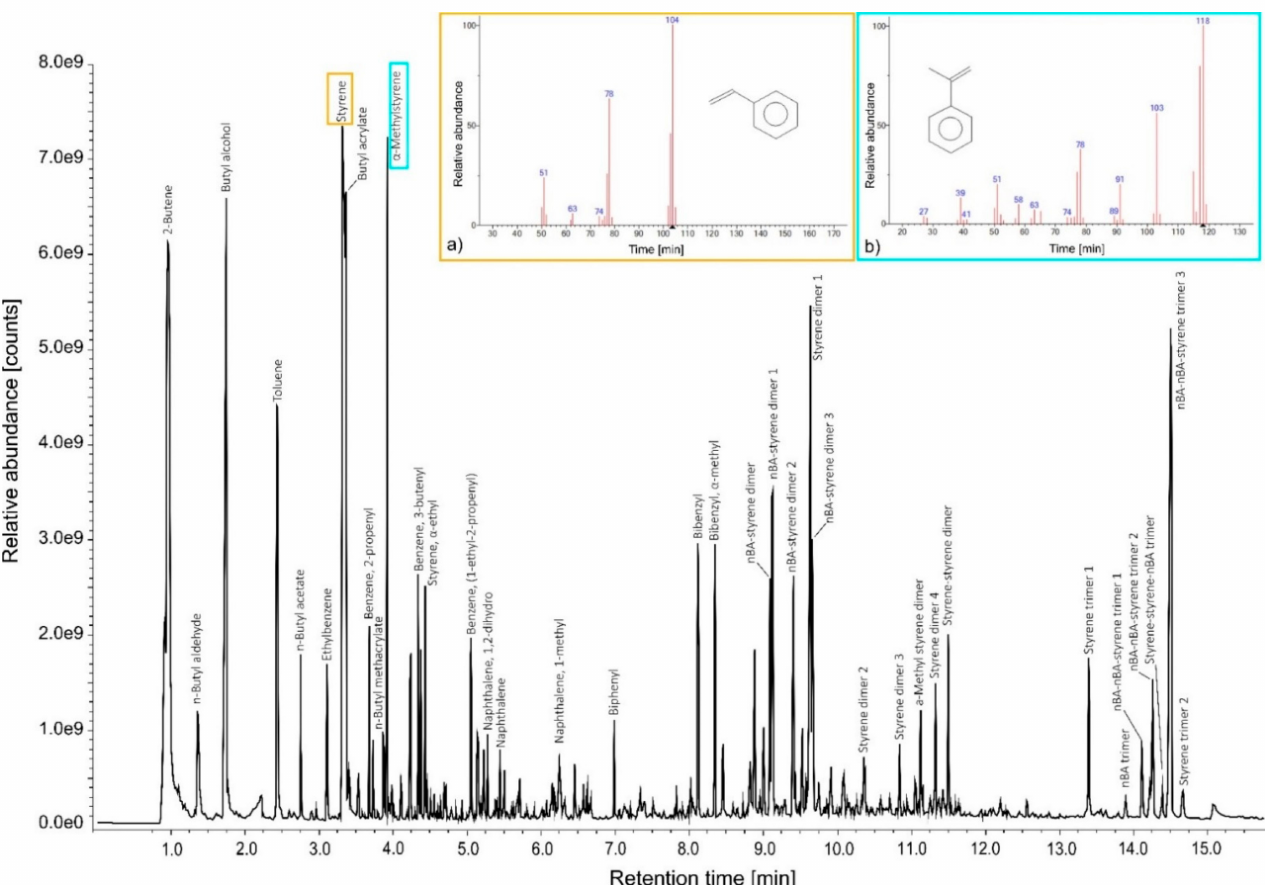
Figure 4. TIC (total ion current) pyrogram obtained after Py-GC/MS analysis of the pure unaged styrene-acrylic emulsion fragments. ( a ) Styrene; ( b ) α -Methylstyrene. Mass spectra of the highest intensity peaks detected are illustrated. All identified compounds are listed in Table